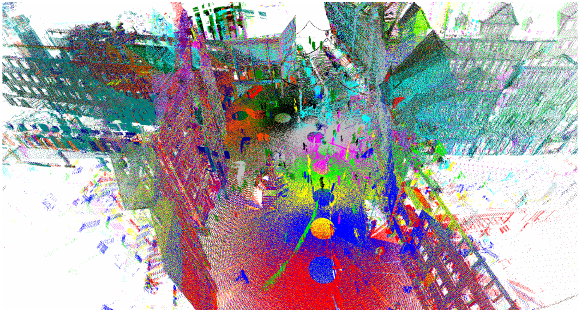
Figure 8. Aligned point clouds when using A-KAZE + M-SURF: the points belonging to different scans S j are encoded with dif- ferent